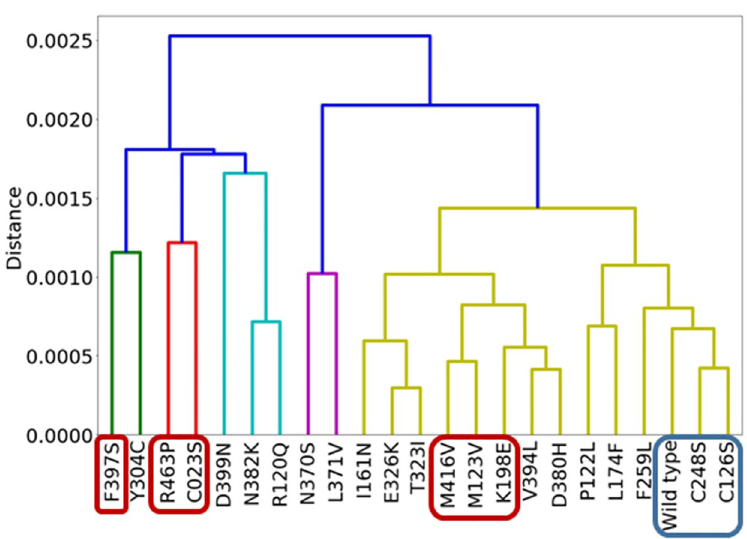
Fig 4. Dendrograph showing clusters of GCase variants based on the DFI of DARC sites. The variants for which experimental data is available show dead enzymes and fully functional (i.e. neutral) enzymes clustered within their own groups. Variants with CRIM_SA values of 0.3 to 1.0 are shown in blue, while variants with CRIM_SA values of 0.06 to 0.1 are shown in red. For other variants shown here, CRIM_SA values are between .1 and .3. These variants have reduced function compared to the wild type, but are still somewhat functional. Higher CRIM_SA values suggest superior enzyme